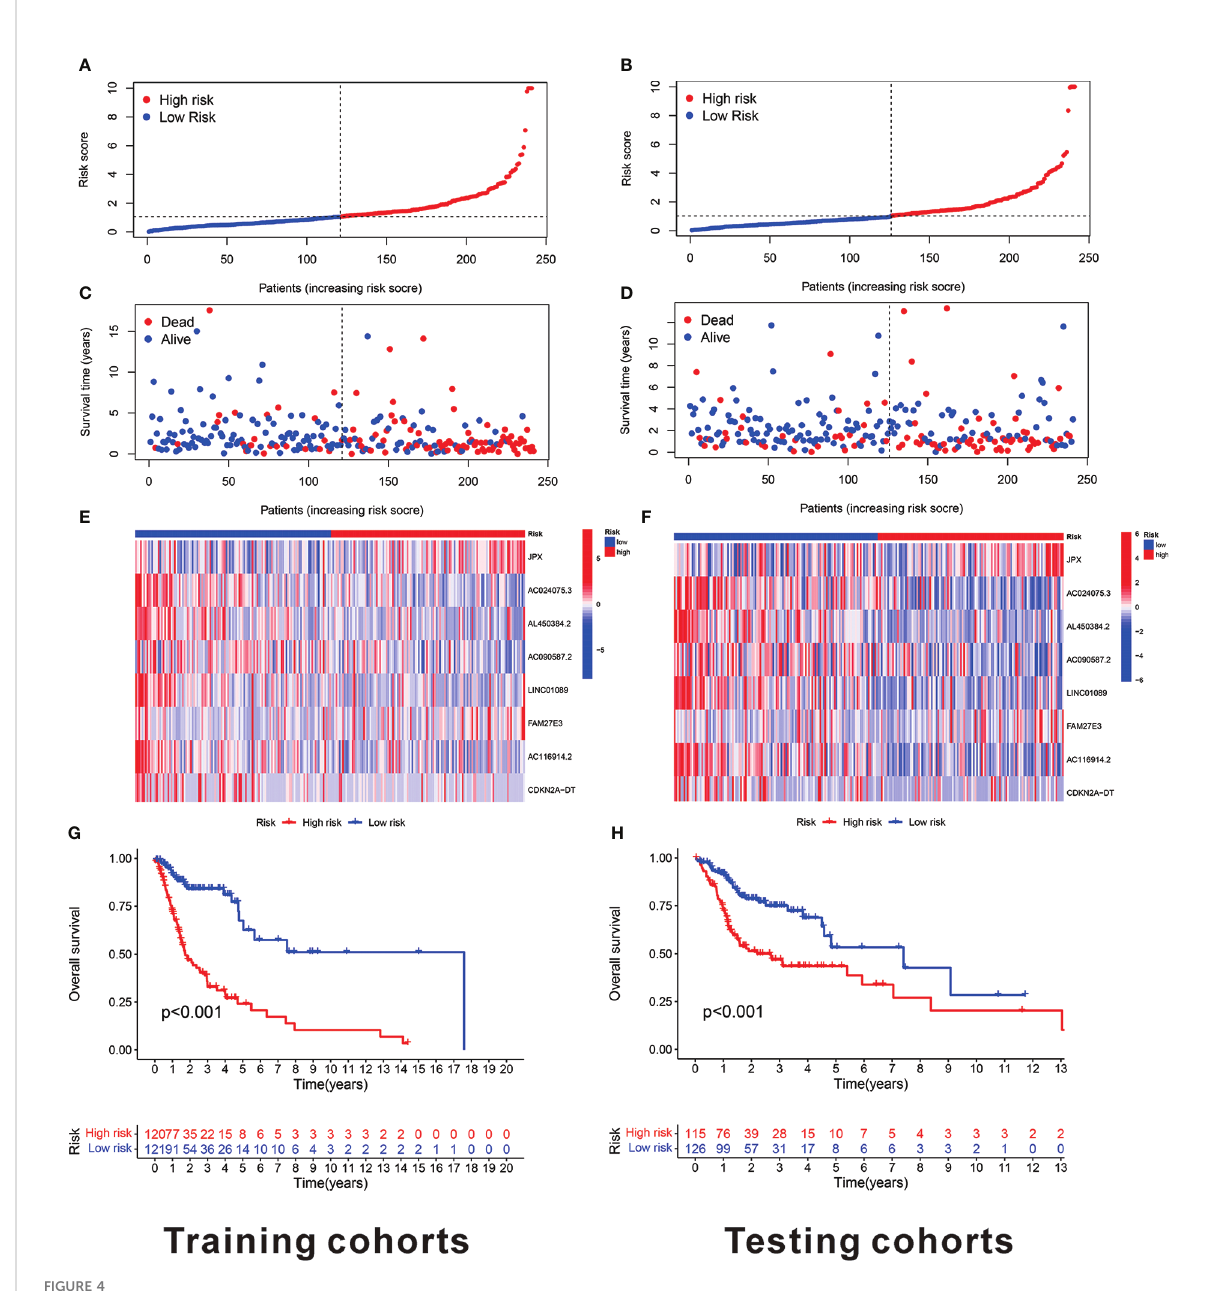
FIGURE 4 The eight cuproptosis-related lncRNAs prognostic value in TCGA training and testing cohorts. (A) The cuproptosis-related lncRNA model-based risk score distribution for training cohorts. (B) In training cohorts, the two risk groups ’ survival time and status patterns. (C) Clustering analysis heatmap reveals that eight prognostic lncRNAs display levels for every patient in the training cohorts. (D) In the training cohorts, the two groups OS Kaplan- Meier survival curves. (E) The cuproptosis-related lncRNA model-based risk score distribution for testing cohorts. (F) In testing cohorts, the two risk groups ’ survival time and status patterns. (G) Clustering analysis heatmap reveals 12 prognostic lncRNAs expression levels for every patient in testing cohorts. (H) In the testing cohorts, the two groups OS Kaplan-Meier survival